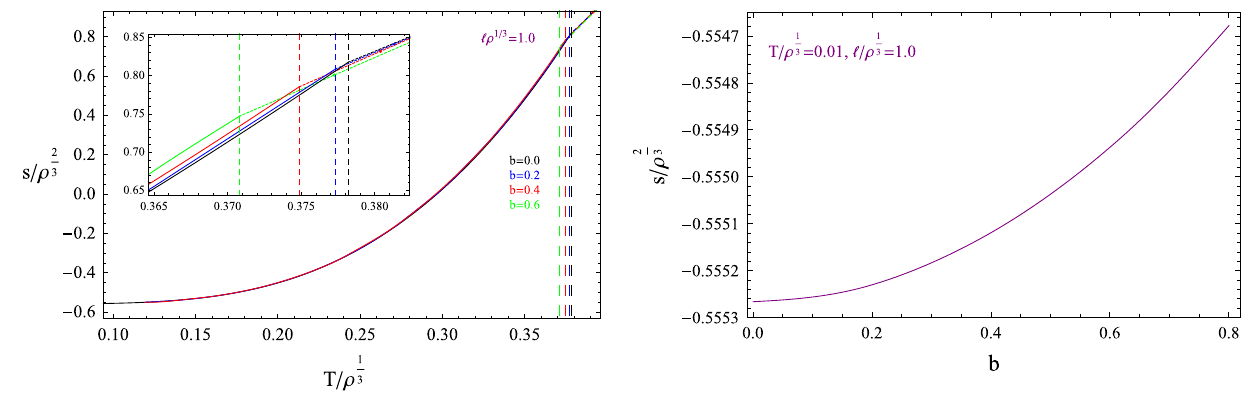
Fig. 4 The entanglement entropy of the operator (cid:2) O − (cid:3) with respect to the temperature T and BI factor b for (cid:14)ρ 1 3 = 1. The four lines in left plot from top to bottom correspond to b = 0 (black), b = 0 . 2 (blue), b = 0 . 4 (red), and b = 0 . 6 (green)